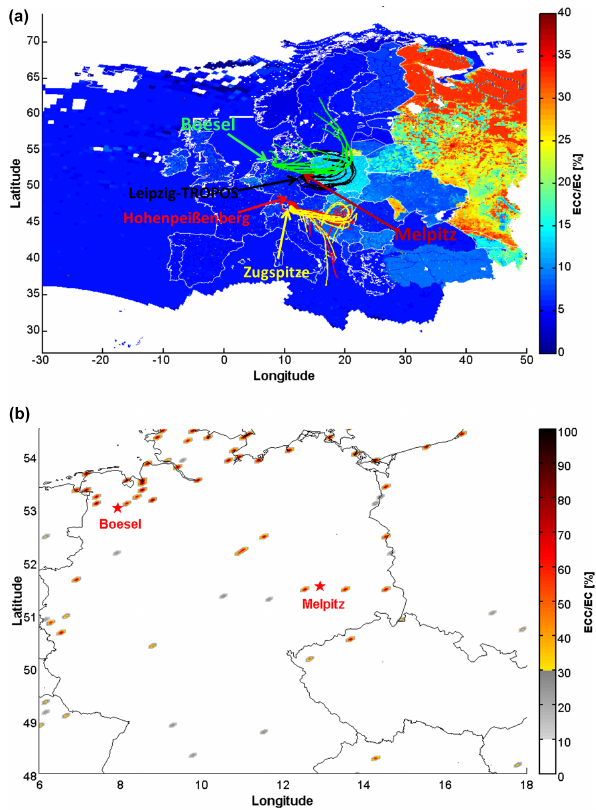
Figure 6. EUCAARI EC emission coarse mode fraction (ECc). (a) ECc result of total emission, including area and point sources. The location of Bösel, Leipzig-TROPOS, Melpitz, Hohenpeißen- berg and Zugspitze are marked on the map. The colored lines in- dicated the 3-day back trajectories for each site (without Melpitz), in the period from 1 April 2009 to 4 April 2009 with 6h interval. (b) ECc result of point source